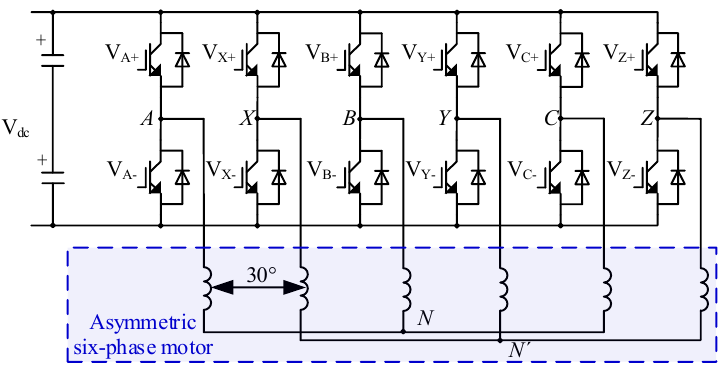
N’ are isolated from each other, all the voltage vectors of the O 1 − O 2 subspace are mapped to the origin.